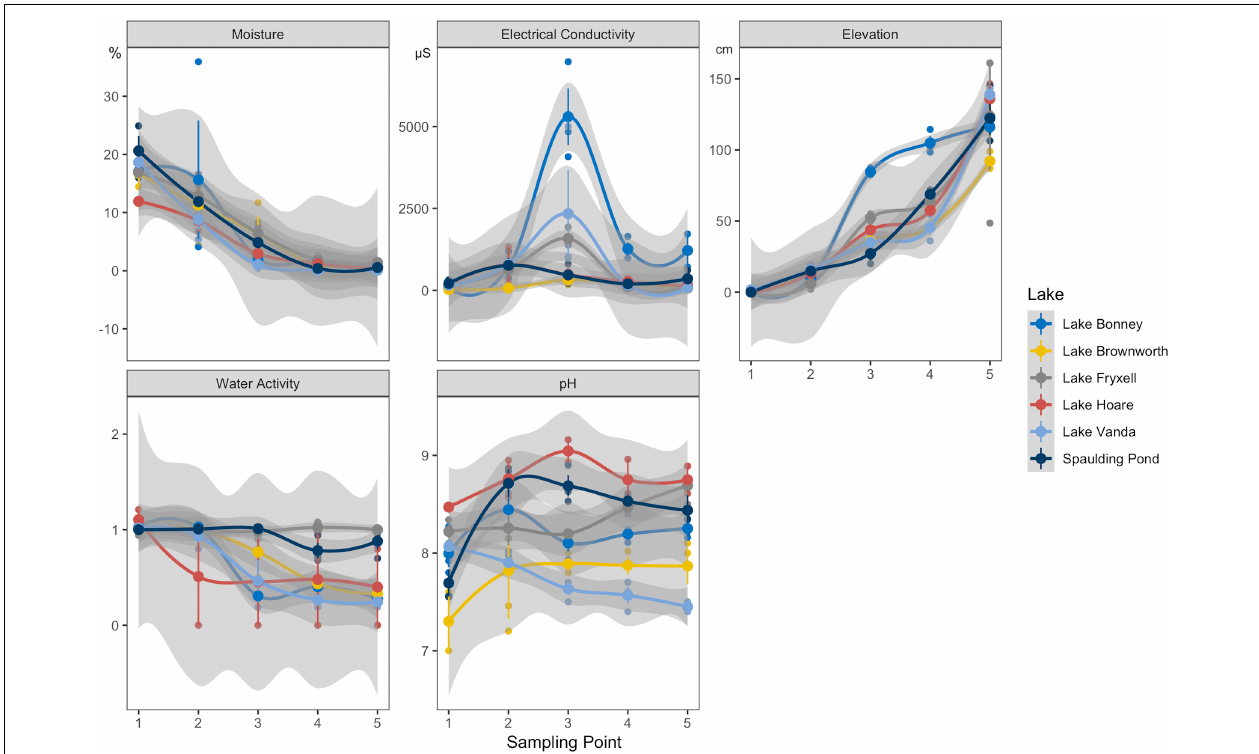
FIGURE 2 | Soil moisture content (%), electrical conductivity ( µ S), elevation (cm), water activity (WA), and pH profiles along the space-for-time transects defined from all major lakes ( n = 3, except for Lake Hoare n = 2) in Taylor and Wright